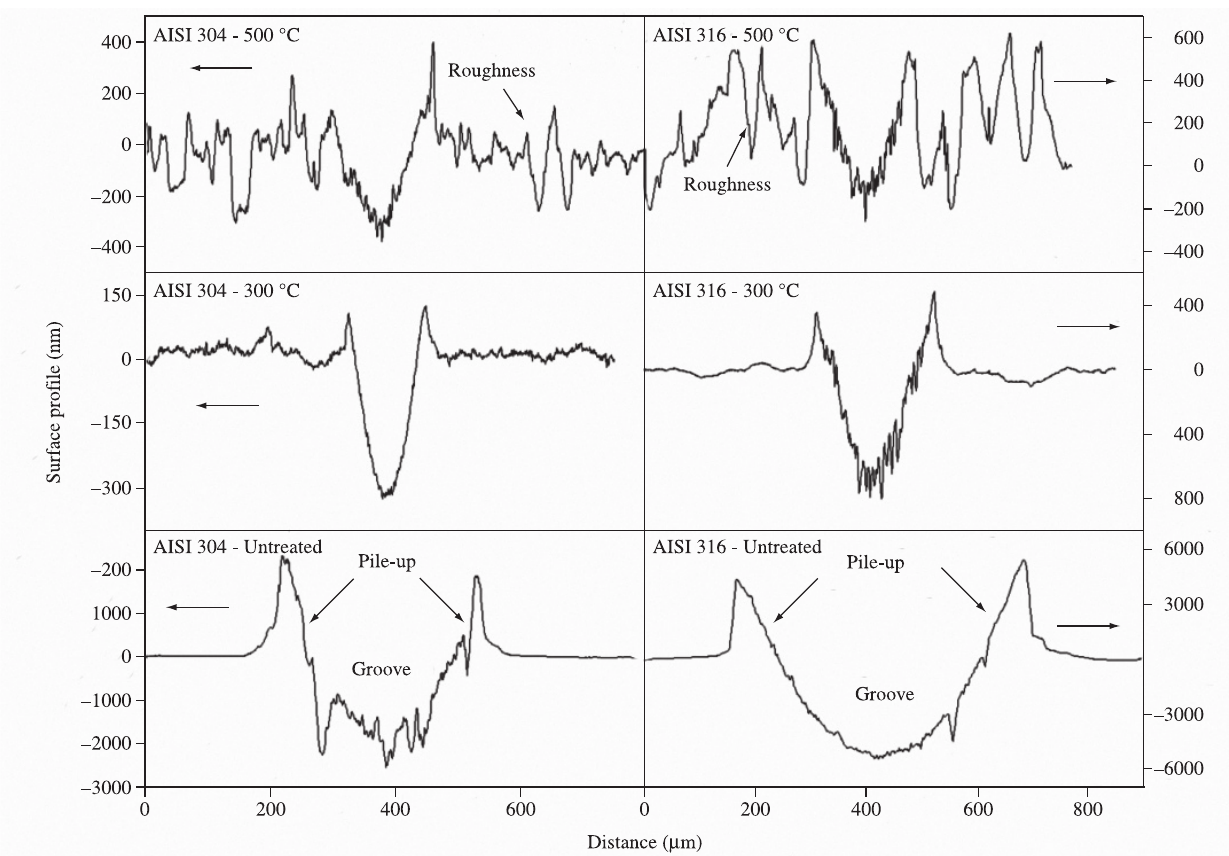
Figure 7. Groove profiles from tribology reciprocating sliding tests for AISI 304 and AISI 316 samples: untreated, and nitrided at 300 and 500 °C. Note the different depth